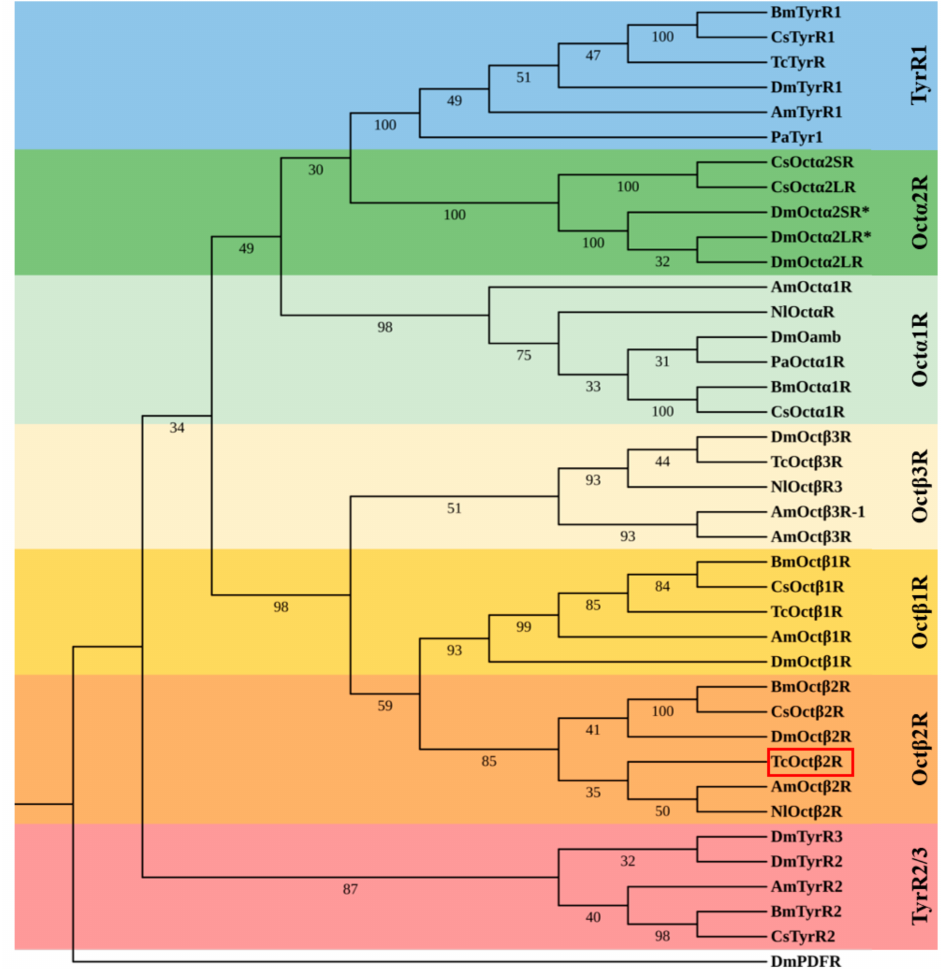
Figure 2. Phylogenetic tree of TcOct β 2R (marked by the red square) and various biogenic amine receptors. The neighbor-joining tree was constructed in MEGA 5.0 using 1000 bootstrap tests. The numbers at the nodes of the branches represent the level of bootstrap support for each branch. The Drosophila PDF receptor served as the out-group. Am, A. mellifera ; Bm, B. mori ; Dm, D. melanogaster ; Cs, C. suppressalis ; Nl, N. lugens ; Pa, Periplaneta americana ; Tc, T. castaneum .The accession numbers of all receptors used in the phylogenetic analysis can be found in Table